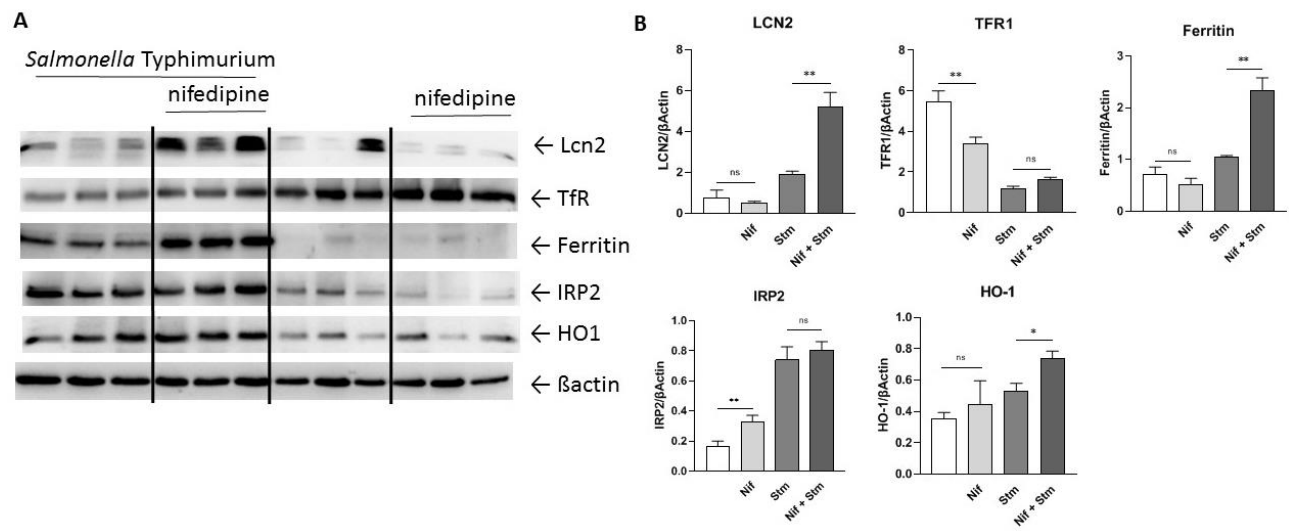
Figure 5. Regulation of iron-related proteins. RAW264.7 cells were infected with Salmonella Typhimurium for 24 h and treated with nifedipine (17.3 µ g/mL) as indicated. ( A ) Western Blot of Tfr1, ferritin, Lcn2, HO1, Irp and β actin. ( B ) Quantification of the Western Blot. Data are expressed as mean ± SEM. One representative Western Blot of three independent experiments is shown. Superscripts indicate statistical significance as follows: * p < 0.05, ** p < 0.01.